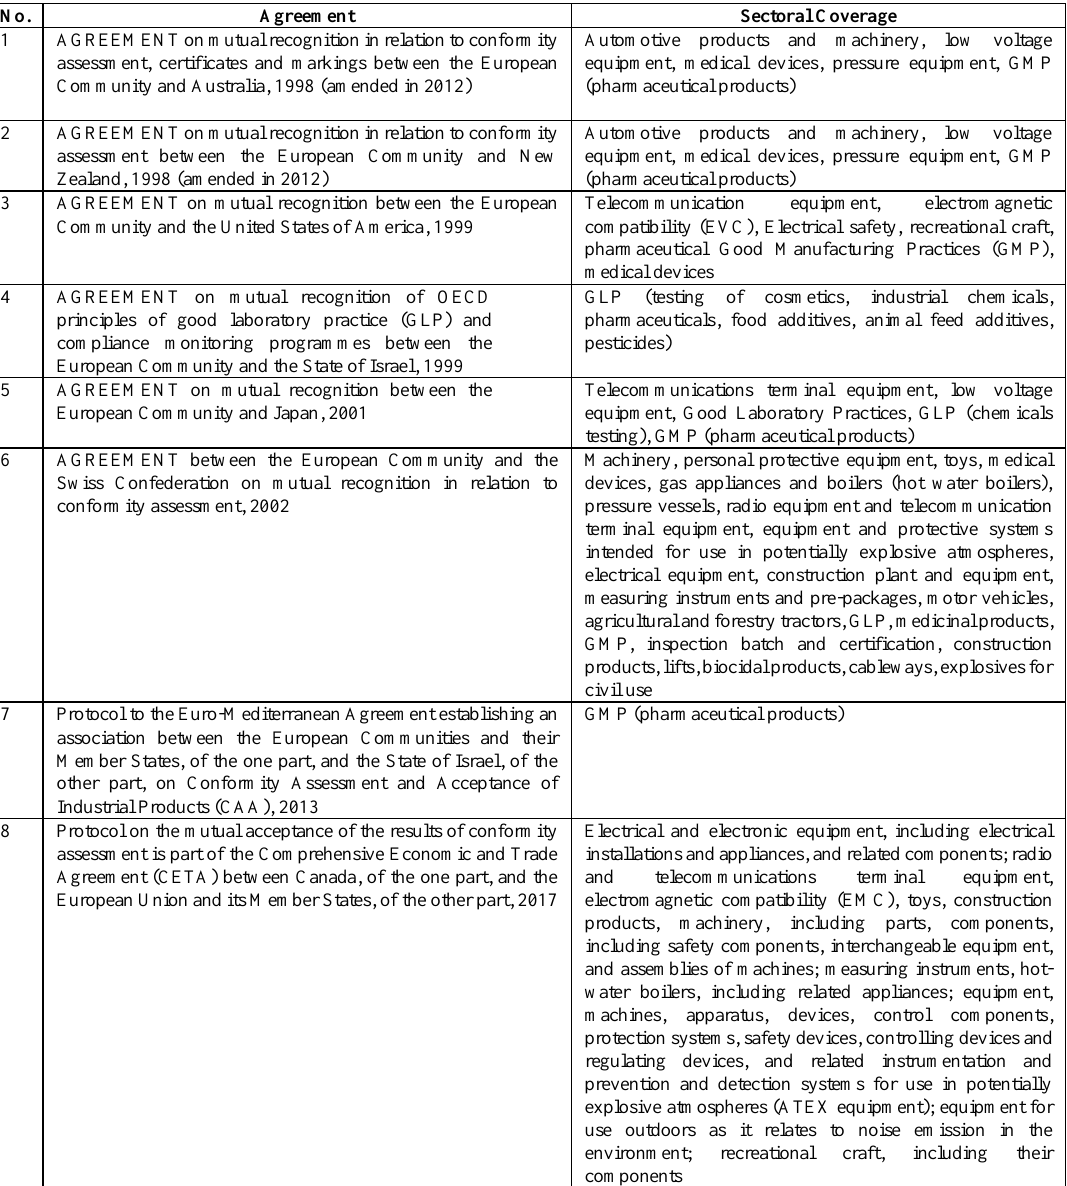
Table 1. Mutual Recognition Agreements between the EU and third